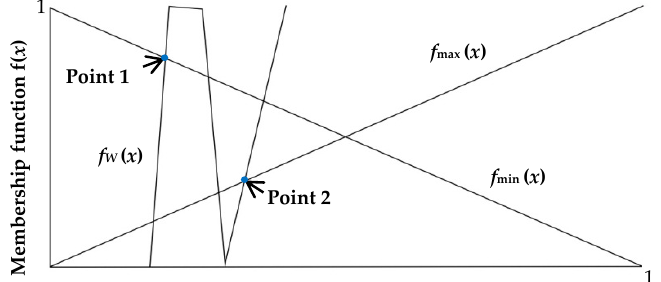
Figure 10. Left and right fuzzy possibility values of fuzzy numbers.